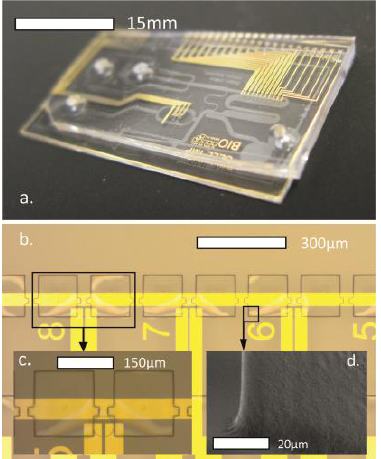
Figure 1. Metal (Au) electrodes integrated in SU-8 based hybrid microfluidic system ( a ); For proper alignment, electric insulation and transparency the channels are formed in multi-layered SU-8 ( b , c ); SEM view presents the interface between the thin insulation and the thick channel forming SU-8 layers ( d